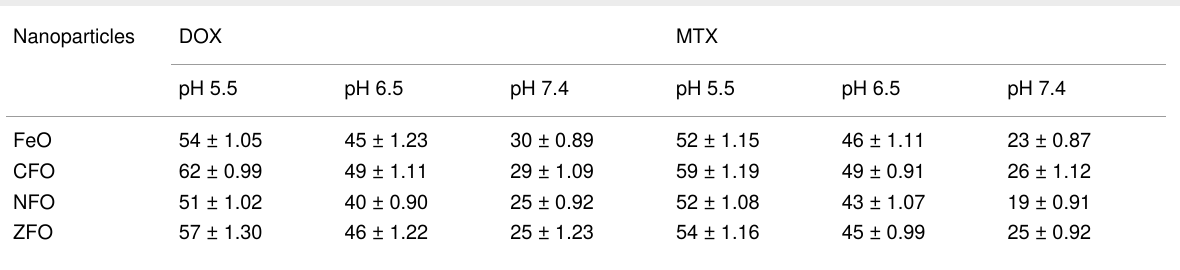
Table 7: Total drug (DOX/MTX) release from MFe 2 O 4 (M = Fe, Co, Zn, Ni) nanoparticles, at pH 5.5, 6.5, and 7.4 after 120 min.